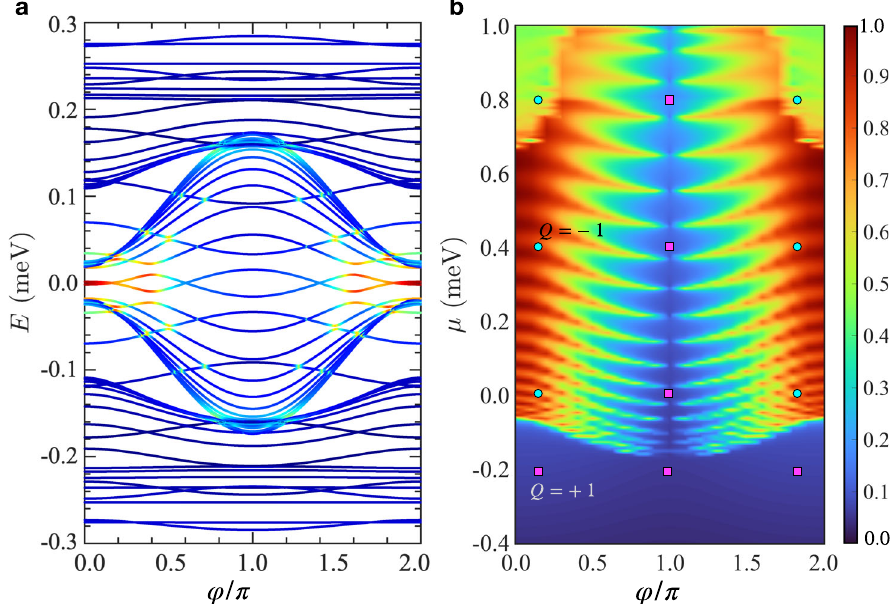
Fig. 4 Phase control of the Majorana bound states. a Quasiparticle spectrum of the planar Josephson junction at a chemical potential μ = 0.5 meV with changing phase difference φ between the two superconducting regions. The skyrmion diameter of the skyrmion crystal was D sk = 10 a . b Colormap of the Majorana polarization of the fi rst positive-energy state in the plane spanned by the phase difference φ and the chemical potential μ . The Majorana bound states appear in the parameter regimes with j P M ; 1 j (cid:5) 1, φ = 0 being the most favorable scenario in this set up. The cyan and magenta dots in b represent the topological invariant, respectively, Q = − 1 (topologically nontrivial) and Q = + 1 (topologically